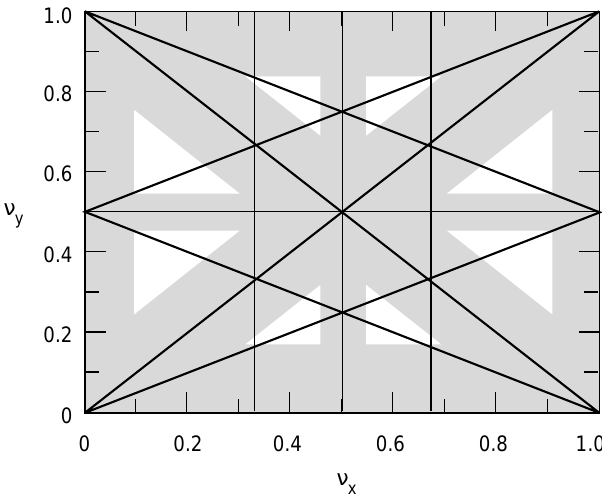
FIG. 14. Tune space with restrictions due to coupling and ver- tical